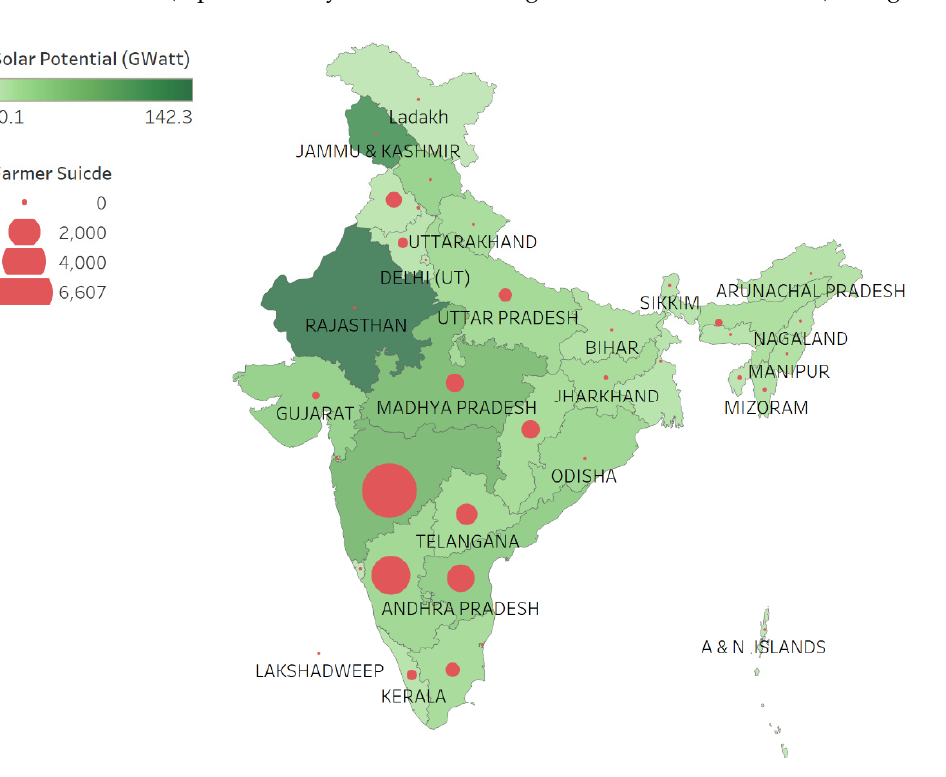
Figure 7. Combining the farmer suicide across India reported in 2019 and solar energy potential estimated by the National Institute of Solar Energy (NISE).